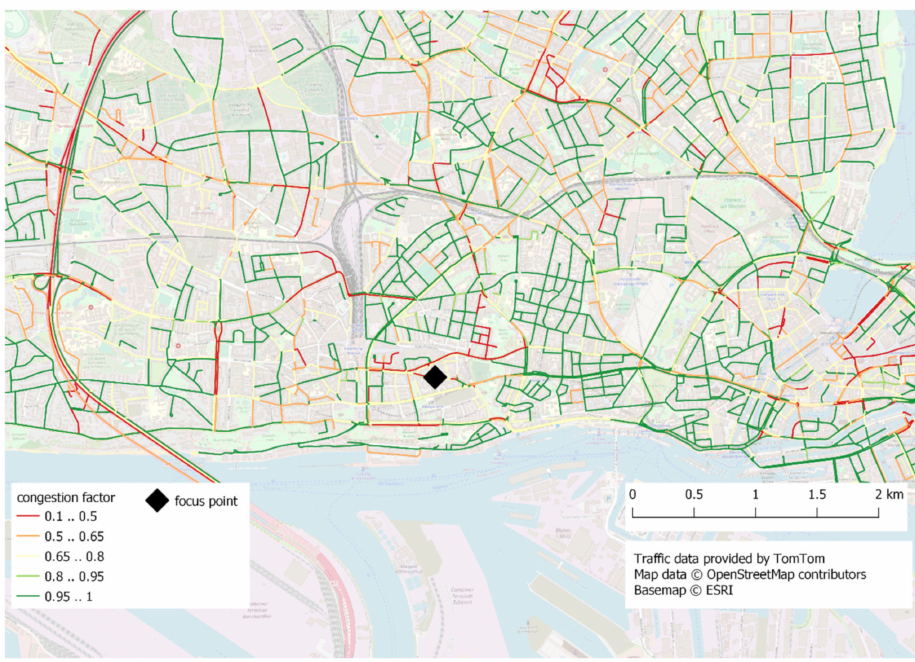
Figure 5. Example 1: Ratio of actual and nominal speed on street segments, using the example of the 16 h afternoon rush hour in Hamburg, on 10 December 2020 (lower congestion factor stands for lower speed, or longer travelling time per edge,